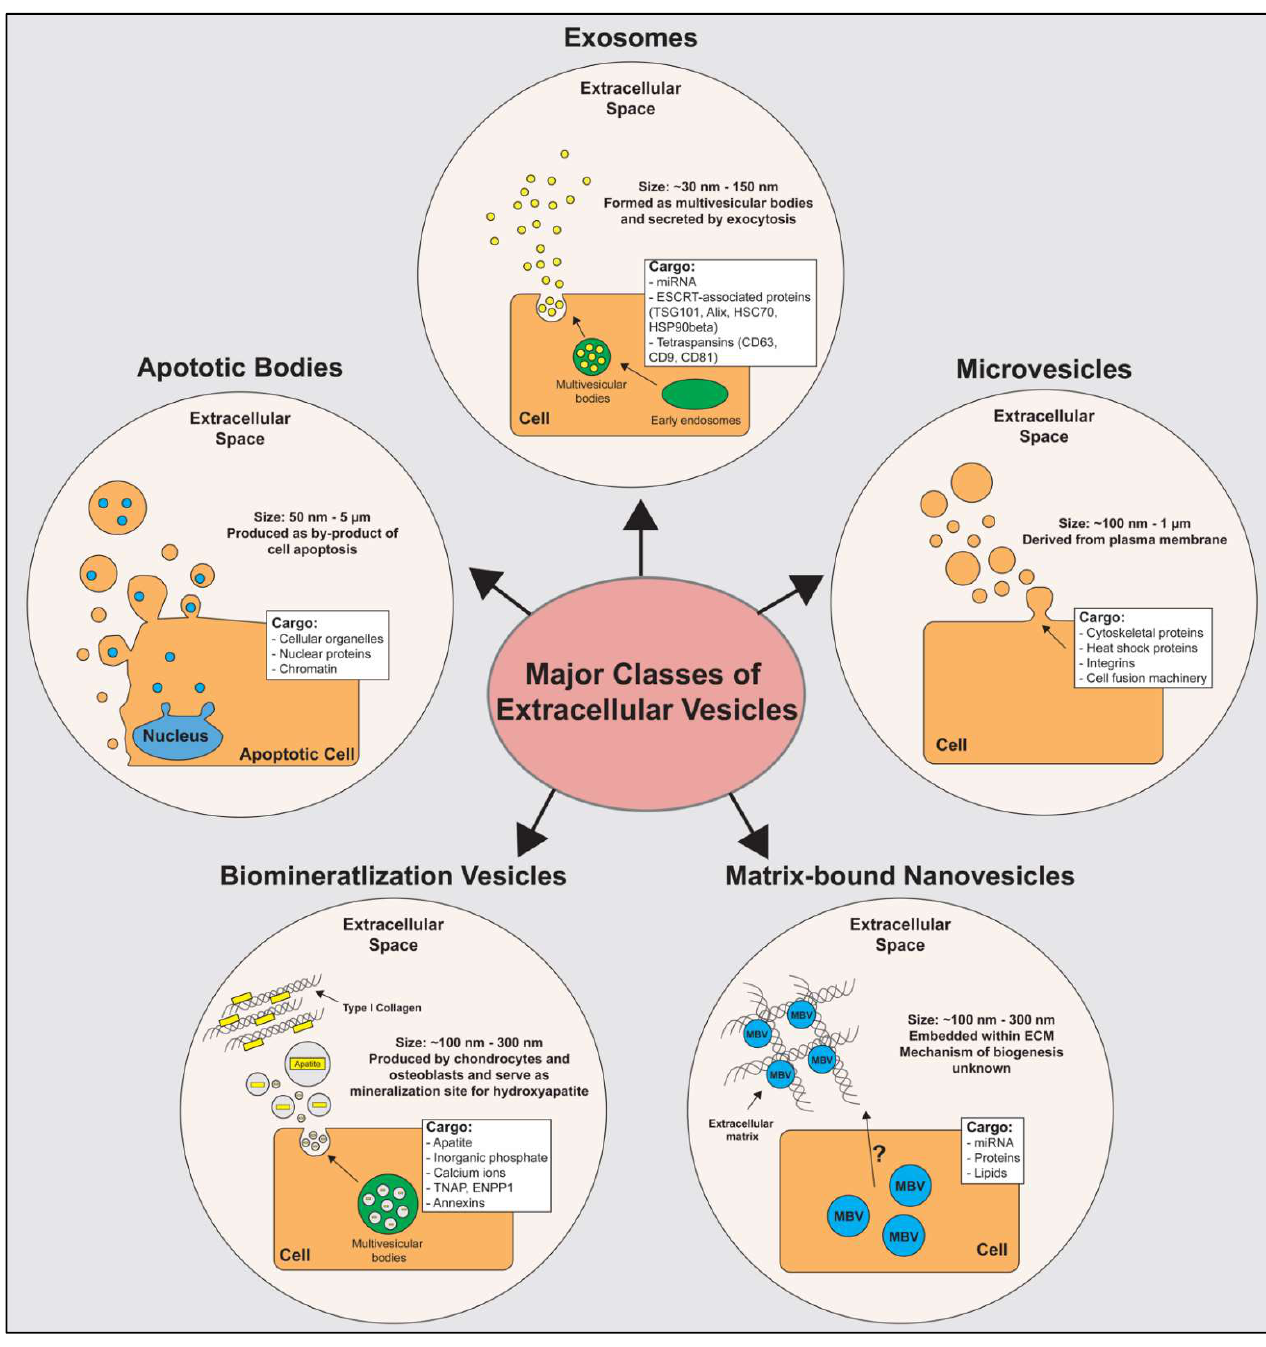
Figure 1. Major subclasses of extracellular vesicles. The five major subclasses of extracellular ves- icles used in tissue engineering and regenerative medicine include exosomes, microvesicles, matrix- bound nanovesicles (MBVs), biomineralization vesicles, and apoptotic bodies. Size, cargo, and bio- genesis of each vesicle subclass are illustrated. Abbreviations; ESCRT: endosomal sorting complexes required for transport machinery; TSG101: tumor susceptibility gene 101; HSC70: heat shock cog- nate 71 kDa protein; HSP90beta: heat shock protein 90 kDa beta; CD: cluster of differentiation; TNAP: tissue-nonspecific alkaline phosphatase; ENPP1: ectonucleotide pyrophosphatase/phos- phodiesterase; MBV: Matrix-bound Nanovesicles.